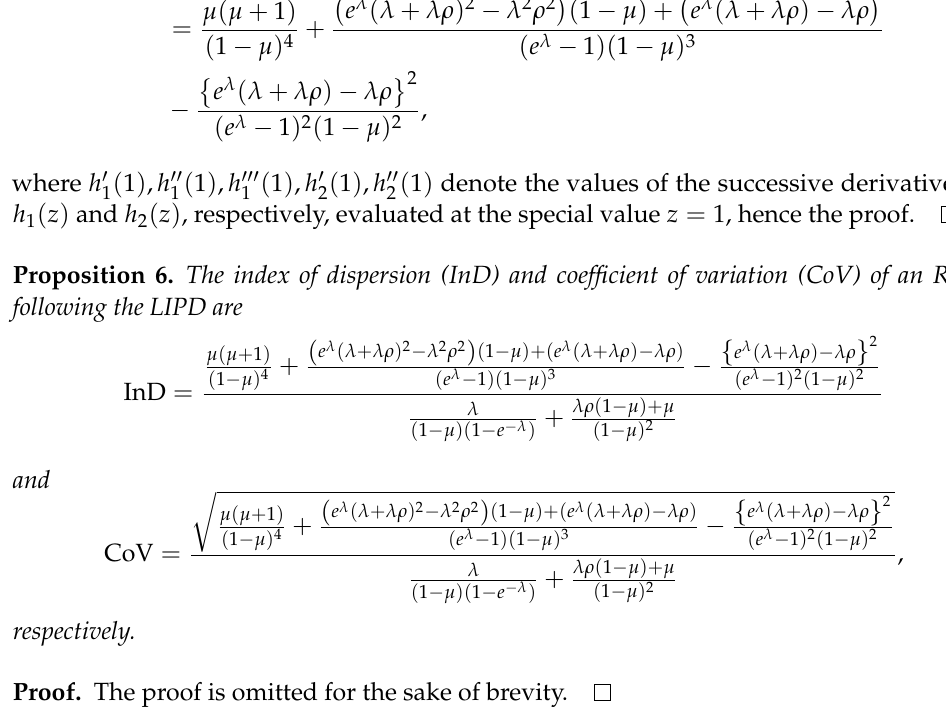
Table 1. Mean, variance, CoV, InD, skewness, and kurtosis coefficients of the LIPD distribution for different values of the parameters.